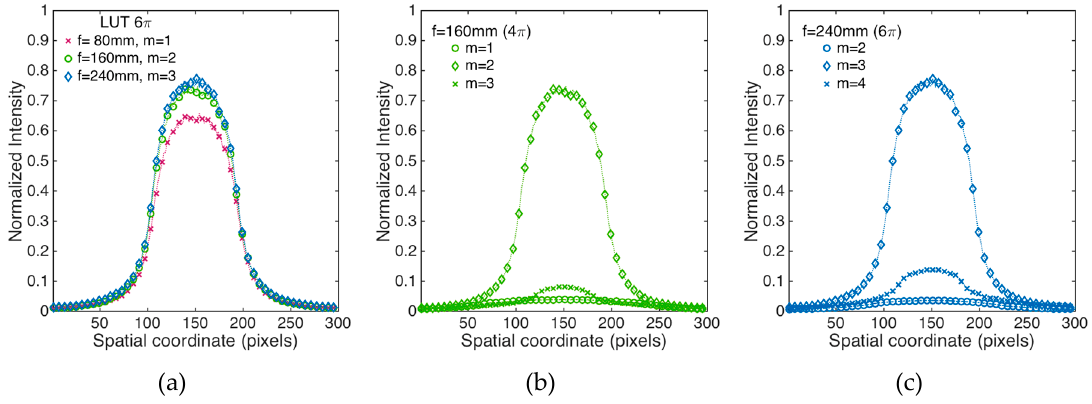
Figure 9. ( a ) Coincident focalization planes at ƒ 0 = 80 mm for first-, second-, and third-order diffraction lenses when the 6 π calibration curve (Figure 6e) is used in all the cases. Different diffraction orders, at different locations, for ( b ) the second-order diffraction lens with ƒ = 160 mm and ( c ) the third-order diffraction lens with ƒ = 240 mm.